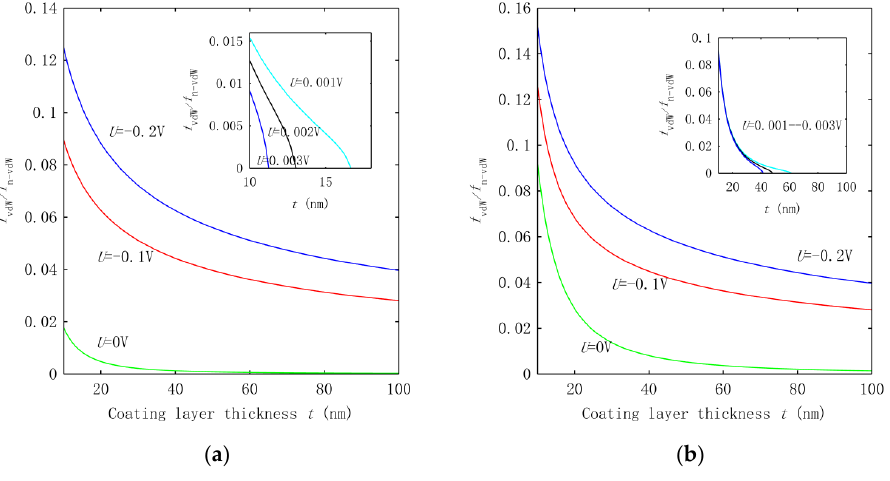
Figure 5. Frequency ratio f vdw / f n − vdw calculated for the HWNs with the SWCNT radius R equal to ( a ) 0.68 nm and ( b ) 2.51 nm.